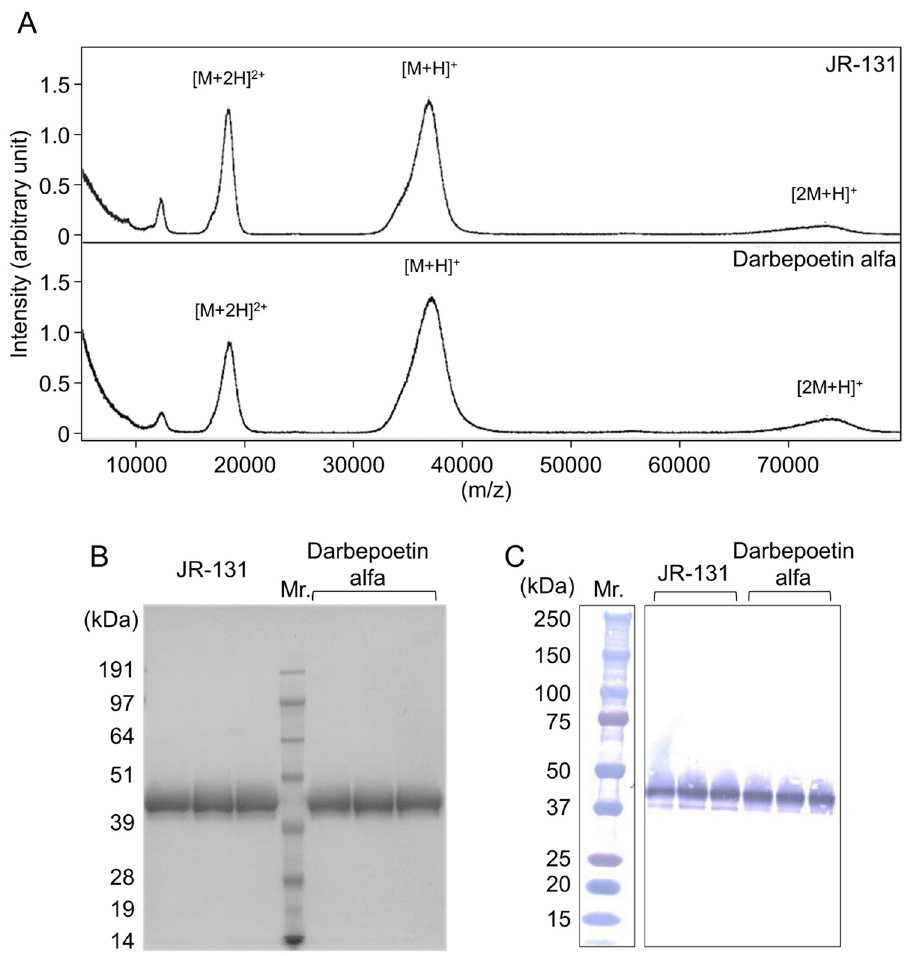
Fig 7. Molecular weight analyses of JR-131 and darbepoetin alfa. (A) MALDI-TOF/MS spectra of JR-131 (upper) and darbepoetin alfa (lower) are shown. (B) SDS-PAGE under reducing conditions showing JR-131 (left) and darbepoetin alfa (right) mobility. (C) Further immunoblot analysis using an anti-EPO antibody. Uncropped gel images are included in S1 Raw images.